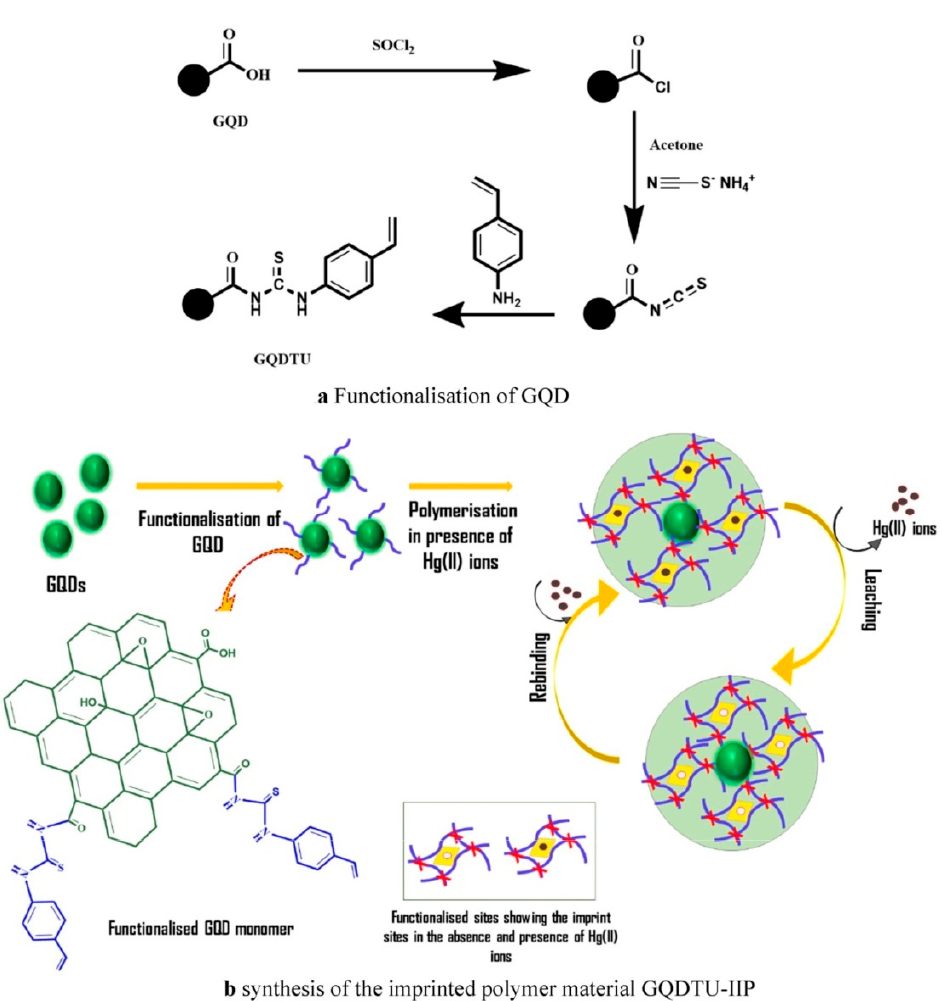
Figure 10. ( a ) Functionalization of GQD ( b ) synthesis of the imprinted polymer material GQDTU-IIP. Reprinted with permission from Ref. [114]. Copyright 2021, the Springer Nature.